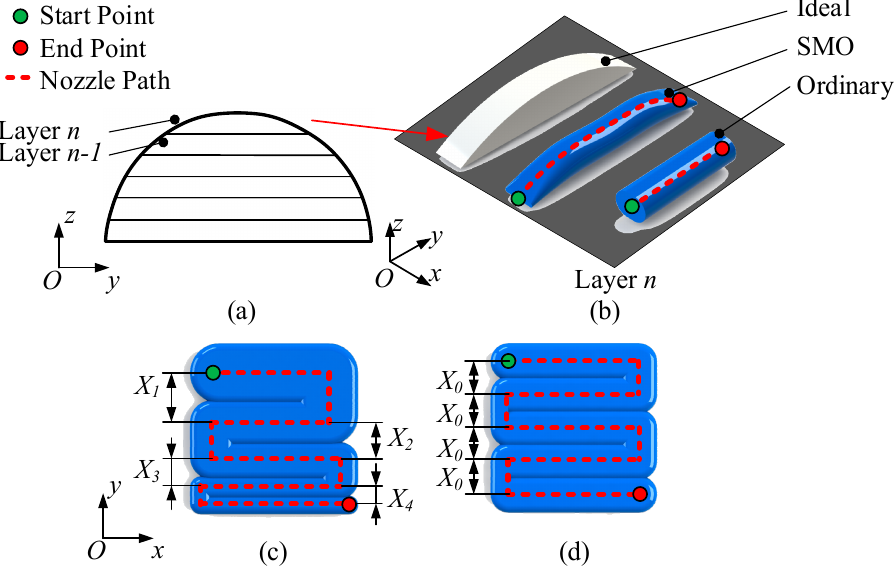
Figure 3. Schematic diagram of SMO method, where the green point is where the nozzle starts printing, the red point is where the nozzle ends printing, and the red dashed line is the nozzle trajectory. ( a ) Schematic diagram of example model, where the profile of the forming direction is a curve, and the model is divided into n layers. ( b ) Comparison of the ability to adjust strand height using different methods, where the product to fabricate is one layer in the example model, and SMO method can adjust the strand height within the range of the maximum and minimum strand height, thus avoiding staircase errors as much as possible, while the ordinary method only uses the set layer height, thus generating staircase errors. ( c ) Schematic diagram of the SMO strategy with strand width adjusted, where X 1 , X 2 , X 3 , X 4 are the ununiform strand spacings. ( d ) Schematic diagram of the uniform strand width strategy, where X 0 is the uniformed strand